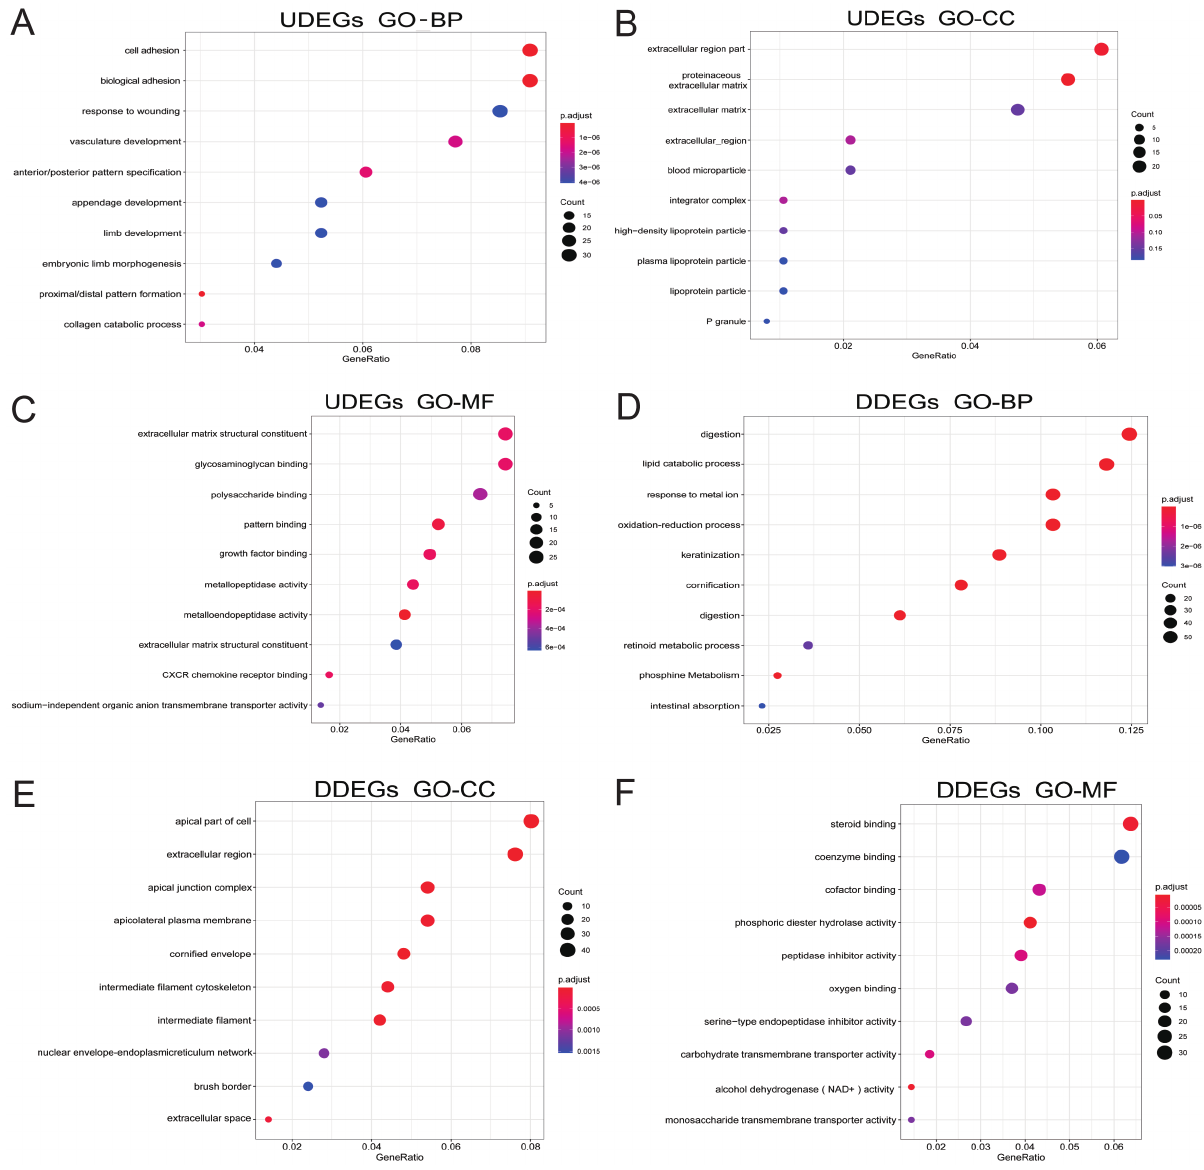
Figure 2. Biological process analysis of differential genes in gastric cancer. (A–C) The results of GO analysis of UDEGs in gastric cancer; (D–F) the results of GO analysis of DDEGs in gastric cancer. CXCR: CXC chemokines; NAD + : Dihydrouracil Dehydrogenase; p. adjust: adjust P -values for multiple comparisons; P granule: germ cell ribonucleoprotein